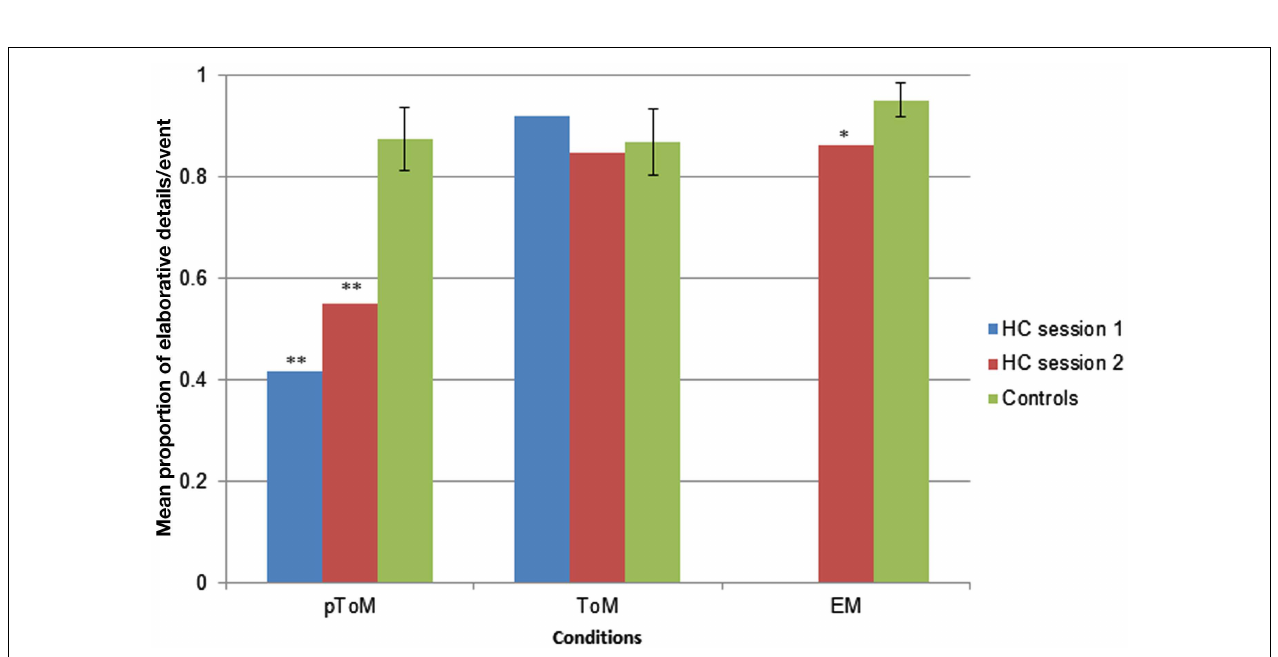
FIGURE 1 |The mean number of elaborative details provided by H.C. and controls in response to each pToM,ToM, and EM event, * p < 0.08; ** p < 0.05. Error bars indicate standard deviations.